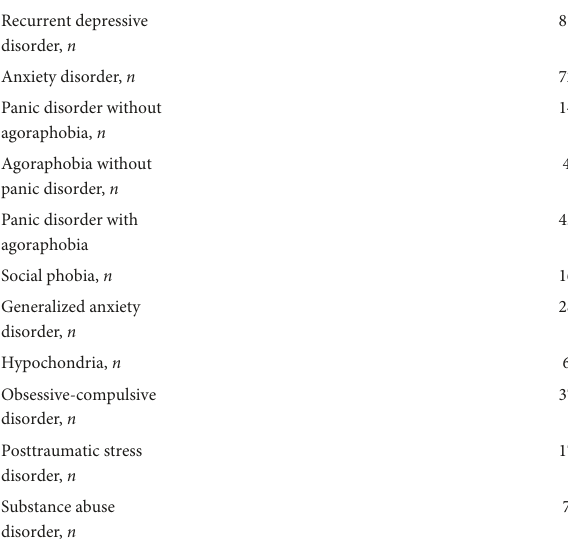
TABLE 2 Frequency of diagnoses according to ICD-10 in the study sample (comprising AD, AD/DD, and DD